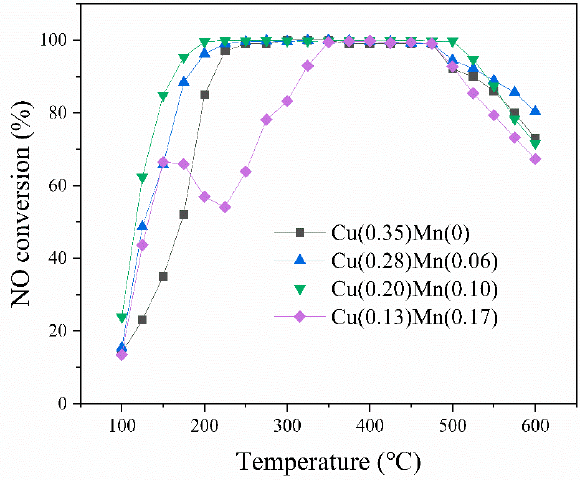
Table 1. Ion exchange degree of catalysts with different Mn/Cu molar ratios.